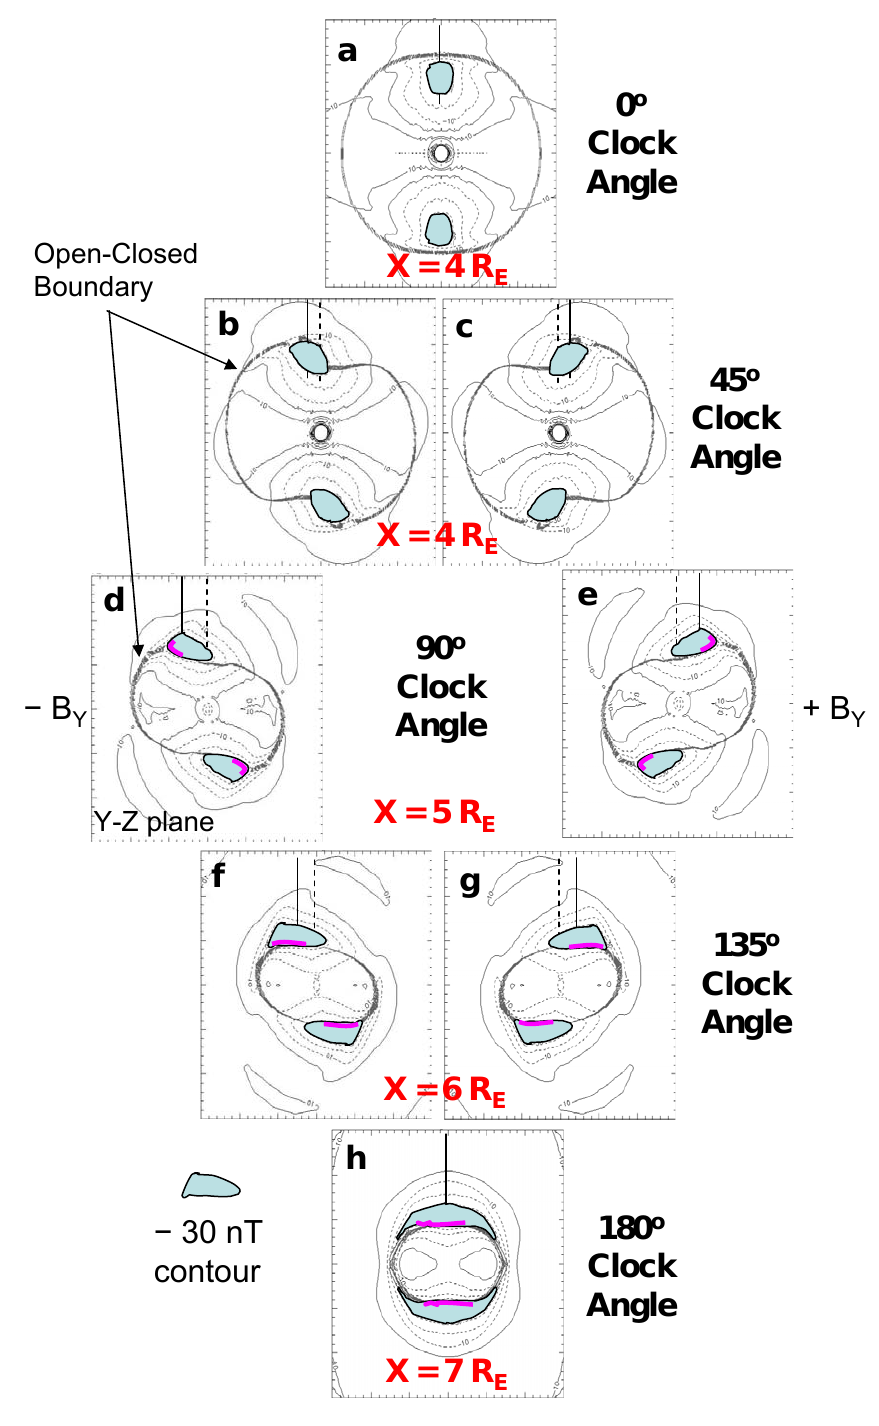
Fig. 15. An adaptation of Fig. 3 from Siscoe et al. (2005) showing contours of 1B derived from ISM simulations using various clock angles but no dipole tilt. Plots show magnetic field differences from a dipole. The YZ plane is shown at the X distance corresponding to the minimum cusp field. The –30nT contour is shaded in to emphasize the cusps position. The red lines suggest locations of probable dayside merging might. The dashed and solid lines indicate local noon and the middle of the cusp depression, respectively. Note the cusp migration toward dusk (dawn) when positive (negative) IMF B Y